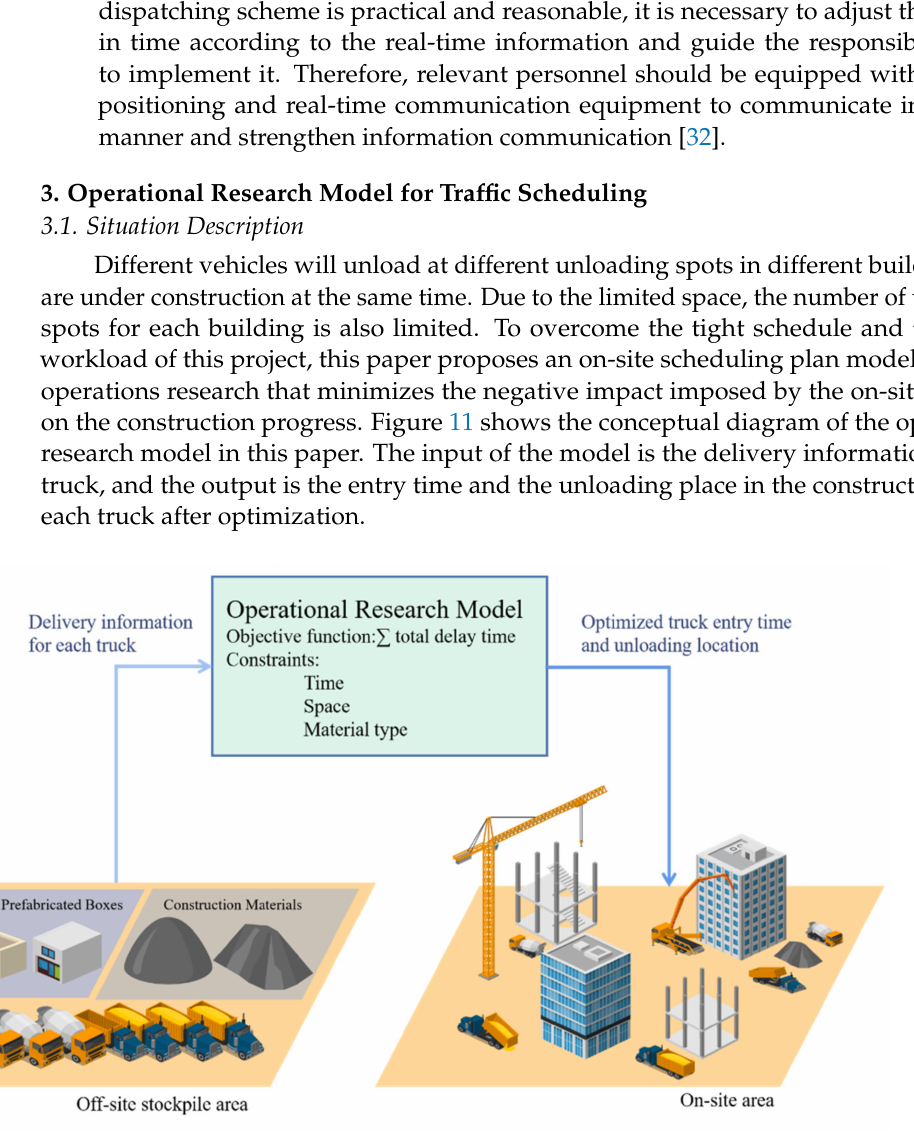
Figure 11. Conceptual diagram of the operational research